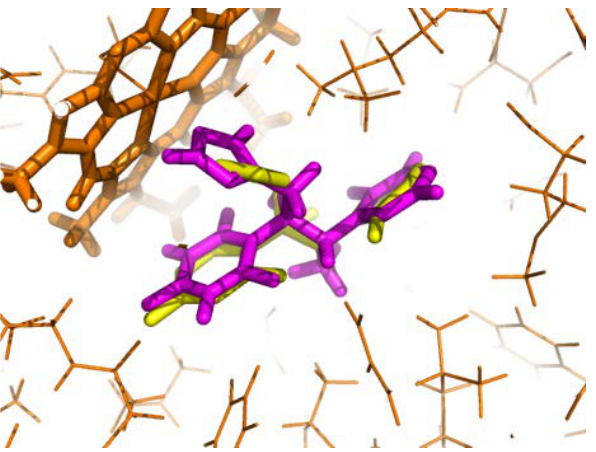
Figure 3. Ligand-binding site of lanosterol-14 α -demethylase with co-crystallized native voriconazole (pink) and posed voriconazole as calculated by the AutoDock Vina program (yellow).